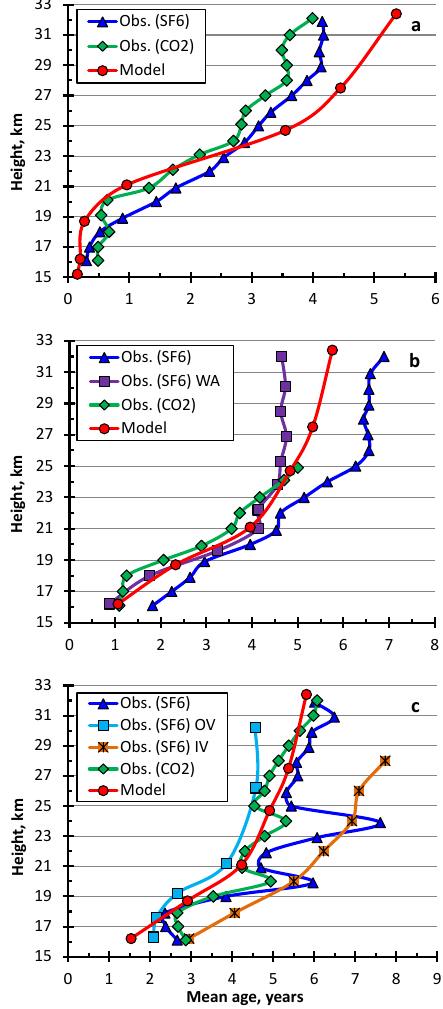
Fig. 2. Comparison of observed and modelled (red lines) mean age of air at latitudes of: (a) 5 ◦ S, (b) 40 ◦ N, and (c) 65 ◦ N. The lines with symbols represent observations: in situ SF 6 (dark blue line with triangles) (Elkins et al., 1996; Ray et al., 1999), whole air sam- ples of SF 6 (purple line with squares for (b) panel, light blue line with squares outside vortex and orange line with asterisks inside vortex (c) panel) (Harnisch et al., 1999), and mean age from in situ CO 2 (green line with diamonds) (Boering et al., 1996; Andrews et al.,